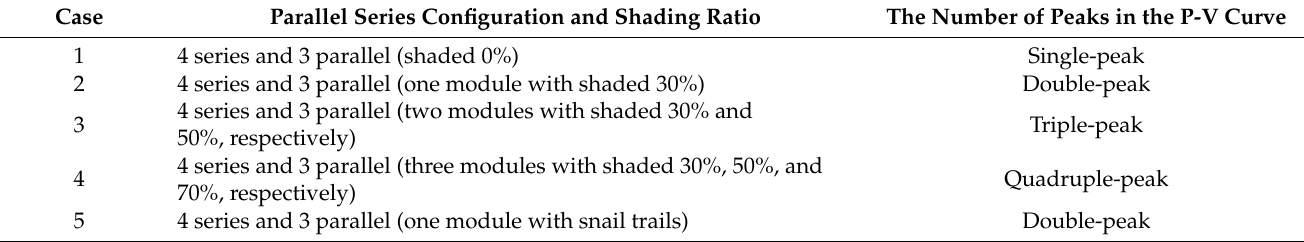
Table 4. Five different shading and failure conditions selected for testing.